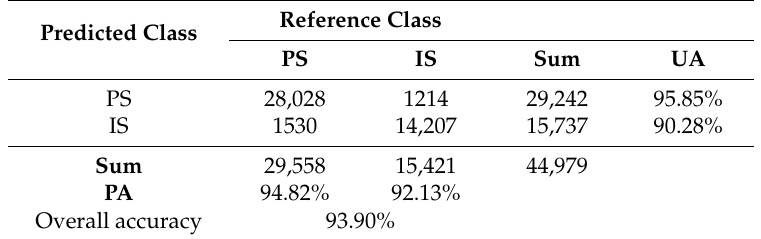
Table 2. Error matrix for the final map using our proposed fine-tuning method.